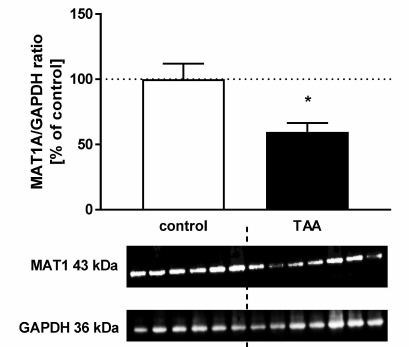
Figure 6. The relative protein level and representative immunoblot of MAT1 (43 kDa) in the liver of control and TAA rats. The graph represents data normalized to GAPDH (36 kDa) and expressed as a percentage of control. Data are reported as mean ± SEM, n = 6–7. * p < 0.05 compared with control.